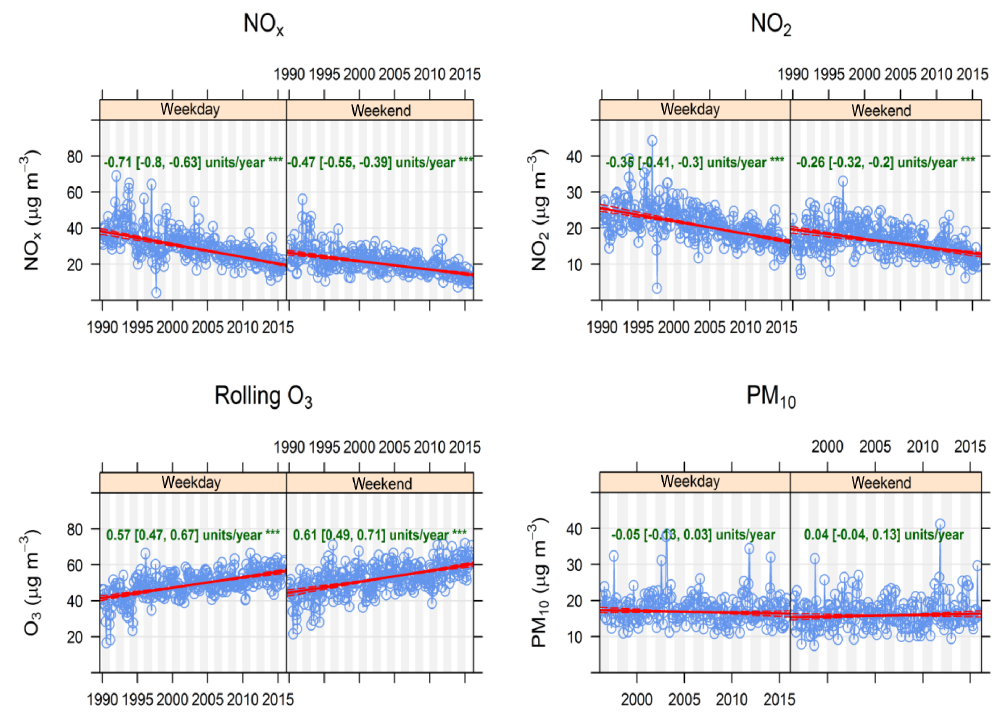
Figure 8. Malmö: the trends for NO x , NO 2 , O 3 , and PM 10 , divided into weekdays and weekends.